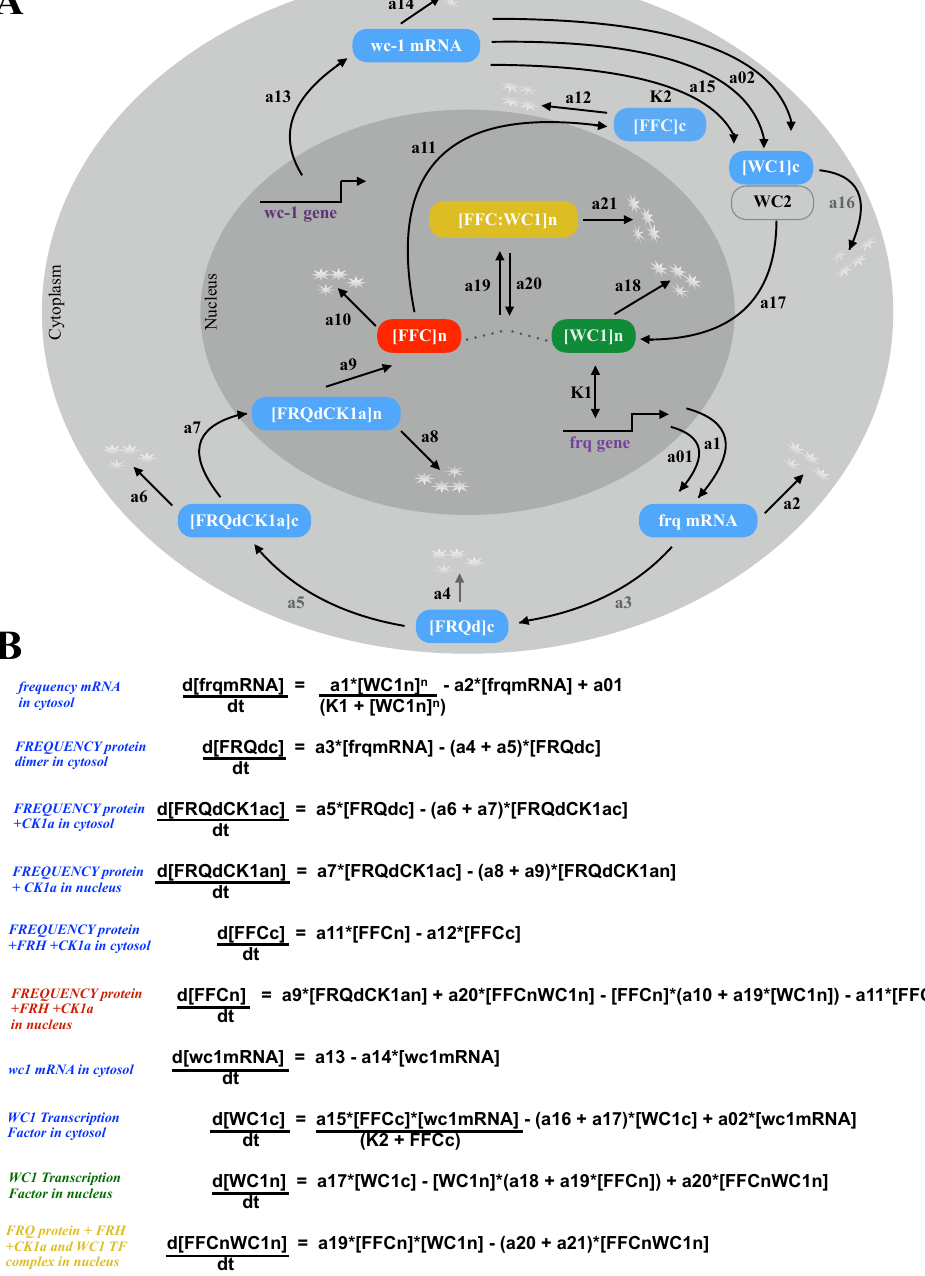
Figure 2. Neurospora circadian clock model: The wiring diagram of the model shows compartmentalization into nucleus and cytoplasm, turnover of frq and wc1 colored in blue, complex formations, and nuclear translocation. The core components of the inactivation switch are marked by green, red, and yellow throughout the paper ( A ). Ordinary differential equations with 10 variables and 26 parameters ( B